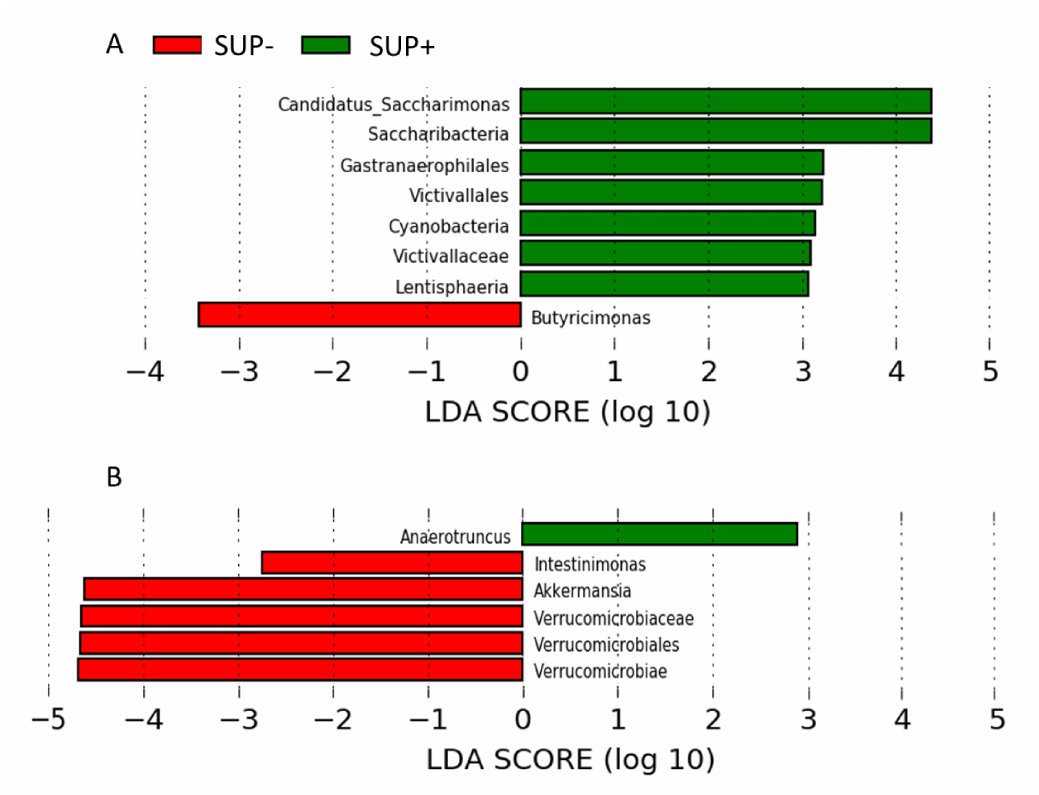
Figure 2. Linear discriminant analysis (LDA) coupled with effect size measurements (LEfSe): The most differentially abundant taxa found in stool samples of unsupplemented piglets (SUP − ; in red, N = 13) or piglets supplemented (SUP+; in green, N = 16) at birth with a mixture of probiotics, prebiotics, immunoglobulins, vitamins, and selenium at ( A ) 16 days of age or ( B ) two weeks post-weaning. Table 3. Discriminative bacteria associated with supplementation in probiotics, prebiotics,